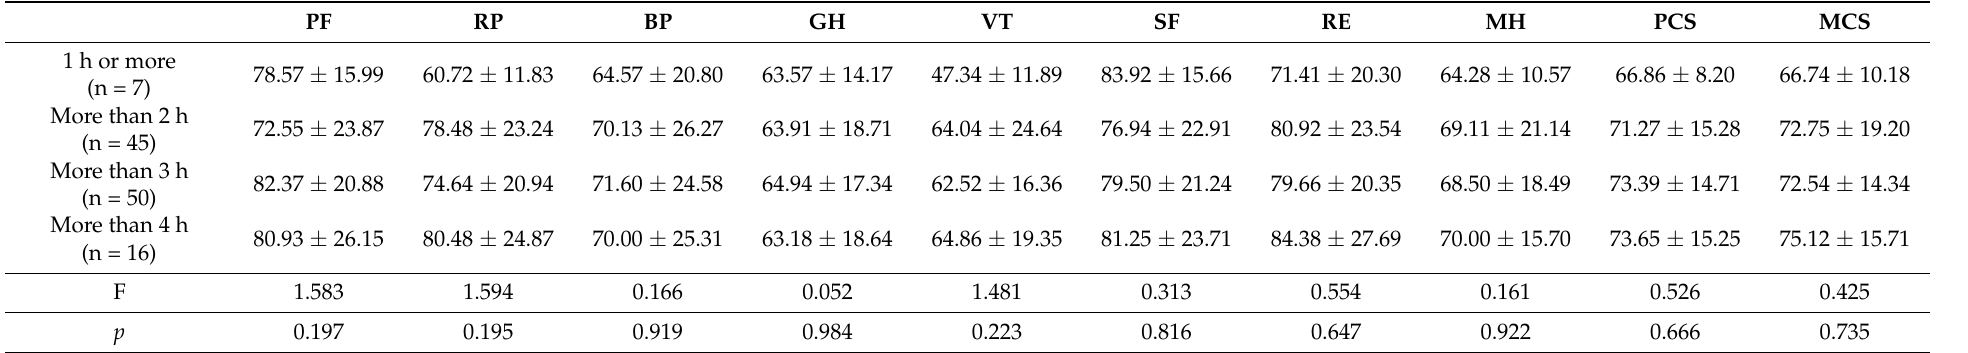
Table 4. Degree of HRQOL according to the time of a single exercise